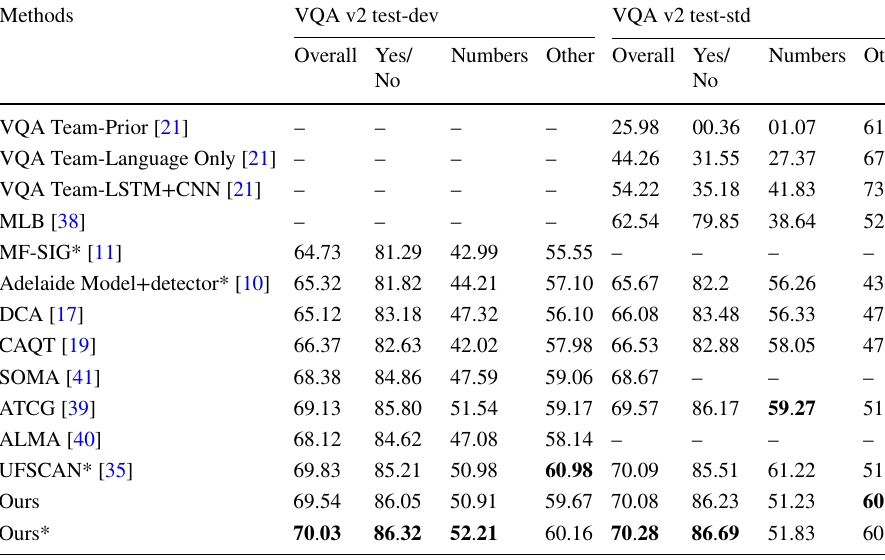
Results in Table 2 are the performance of a single model of the compared methods on the same training set. “*” indicates augmented with VG [30] dataset. “–” indicates the result is not available. “Overall” represents the final overall accuracy. “Yes/No”, “Num”, and “Other” respectively indicate the accuracy of three differ- ent question types under the subdivision Bold value is the best among all